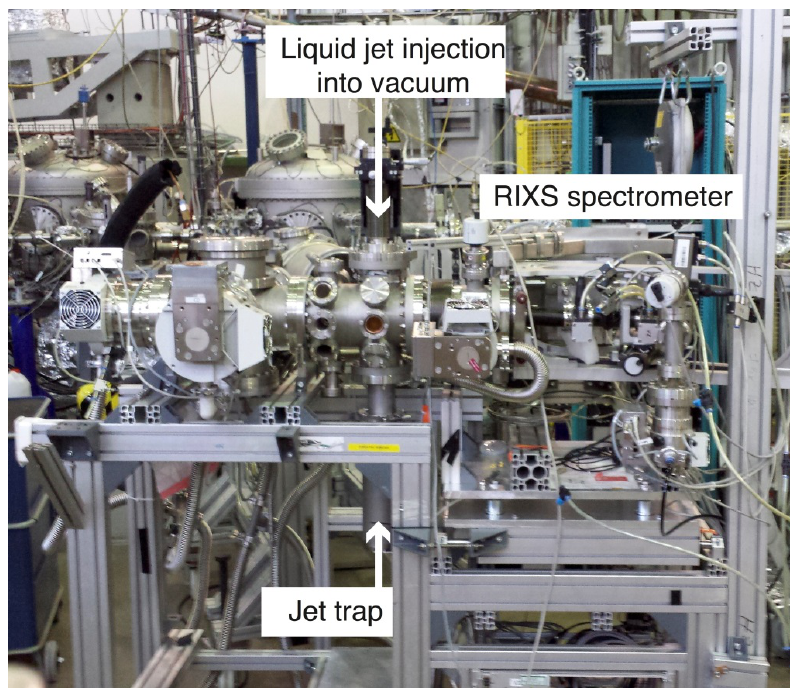
Figure 1: View of the Liquid flexRIXS end station.